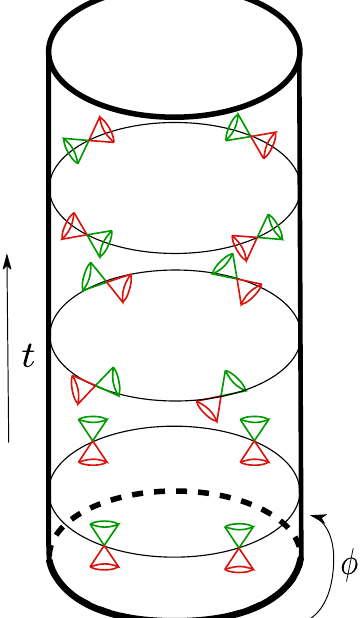
Fig. 7 We represent here a cylinder R × S 1 endowed with the light cone structure of Misner spacetime. At t = −∞ , the lightcones seem to have a “normal” causality in the sense of not allowing closed causal curves. They get tilted as we move from t = −∞ to t = 0, where one of the generators of the light cones is perpendicular to t . Hence, at t = 0, we got the first closed causal curve: a light ray that is confined to such circle. This t = 0 slice corresponds to the circle in the middle of the three drawn. For t ≥ 0, we enter into the regime of abnormal causal behaviour containing closed causal curves. Notice that, although we are still using conic symbols for the light cones, we are again in 1 + 1 spacetime dimensions and they are not strictly “cones”